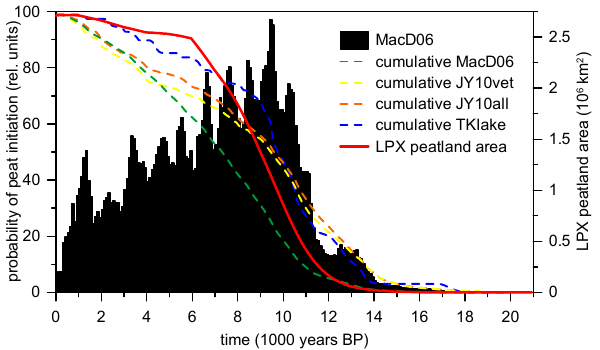
Fig. 3. Comparison of northern peatland area development in LPX with peat initiation data from various basal ages as compiled by Reyes and Cooke (2011). Shown are the circumpolar peat initia- tion probability and their cumulative curve (MacD06; MacDonald et al., 2006). Other cumulative basal dates are given for peatlands in Alaska (JY10vet, JY10all; Jones and Yu, 2010) and thermokarst lakes (TKlake; Walter et al.,